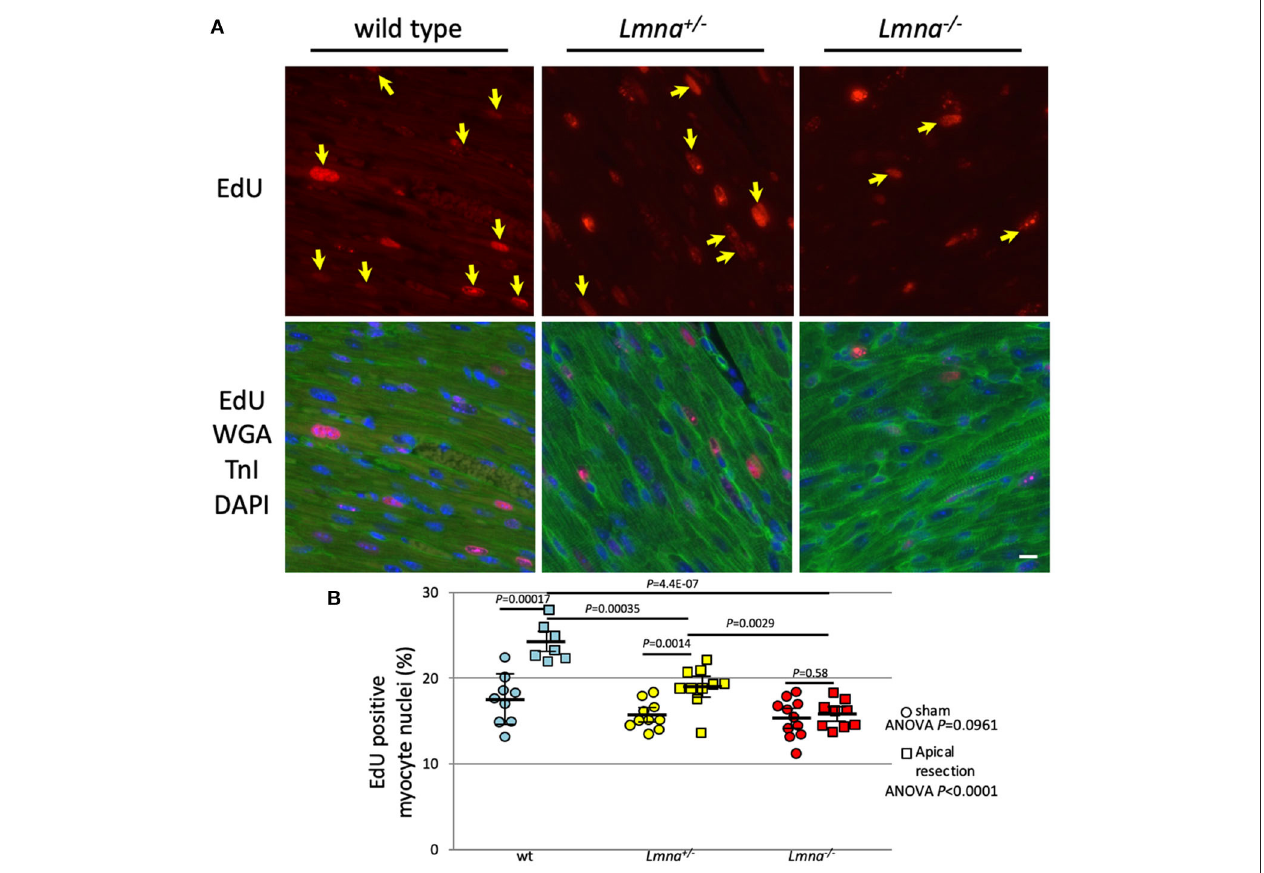
FIGURE 5 | EdU incorporation and the percentage of EdU positive myocyte nuclei after apical resection. (A) Representative immunostaining for EdU in cardiac tissue sections of wt, Lmna + / − , and Lmna − / − . The top panel shows EdU staining, and the bottom panel shows merged figures of immunostaining for EdU (red), WGA, and troponin I (green) and DAPI (blue). Yellow arrows indicate EdU positive nucleus only in cardiomyocytes. Scale bar: 10 µ m. (B) Percentage of EdU incorporated myocyte nuclei ( n = 7 to 11 in each group). A circle indicates data from mice with the sham operation, square with apical resection. Dots represent individual mouse data. The significance of differences between 3 groups was determined with 1-way ANOVA. Post-hoc pairwise comparisons were performed with Tukey–Kramer